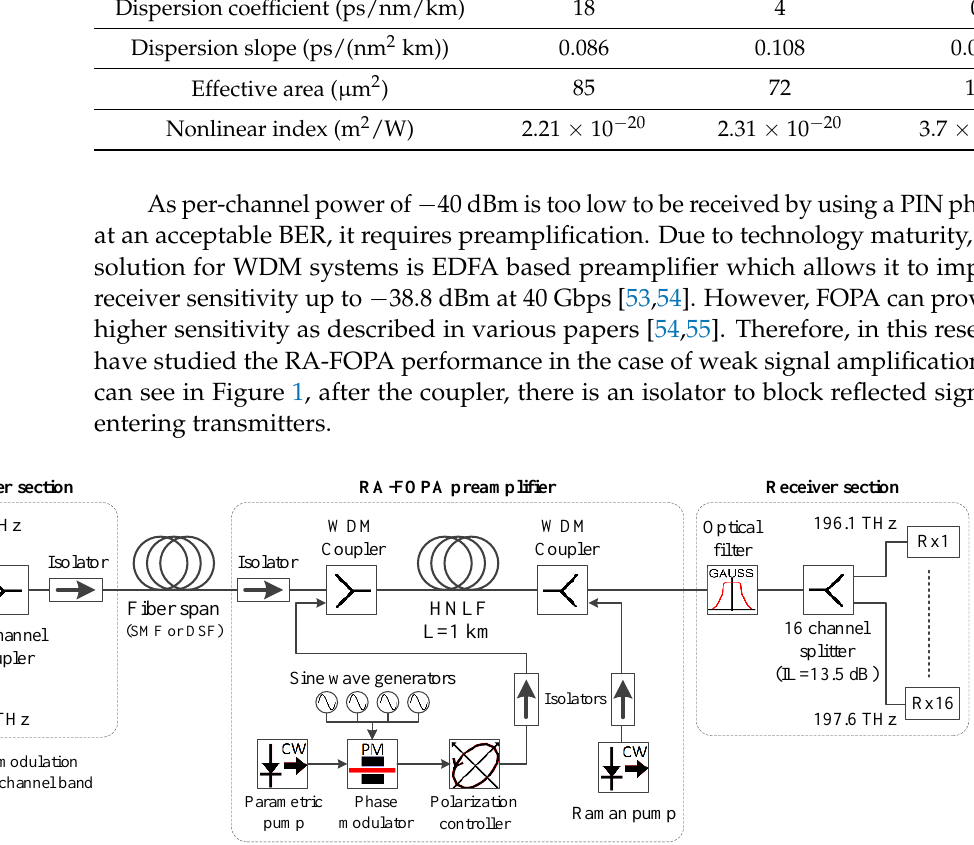
Figure 1. Simulation scheme of Raman assisted fiber optical parametric amplifiers (RA-FOPA) preamplifier in the 16-channel wavelength division multiplexing (WDM) system.